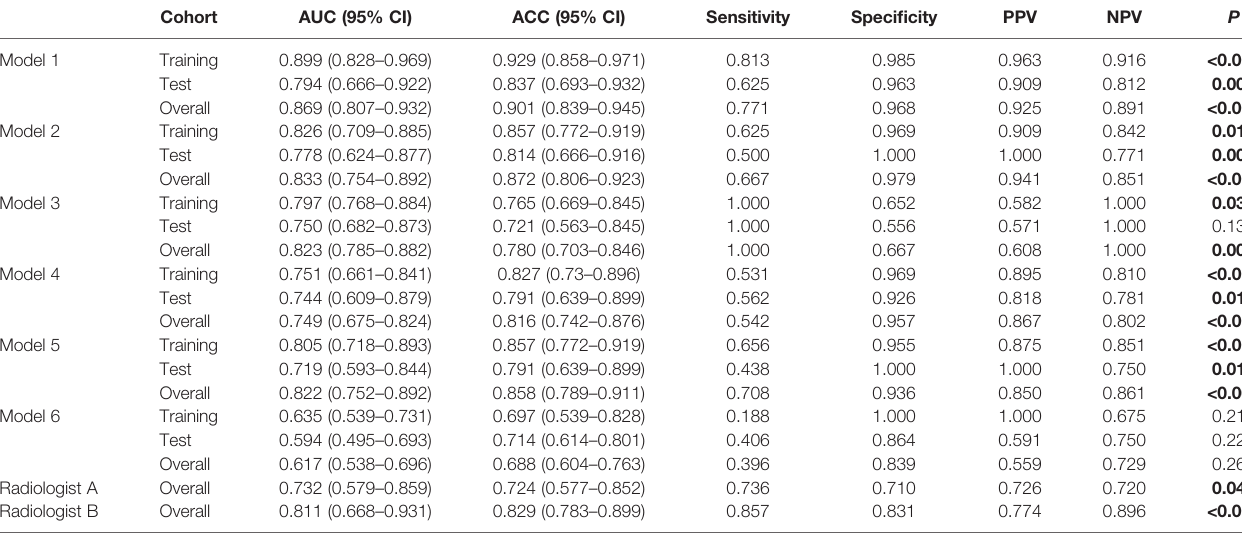
TABLE 5 | Diagnostic ef fi cacy of different models and radiologists ’ assessment in differentiating PCNSL from aGBM. Cohort Model